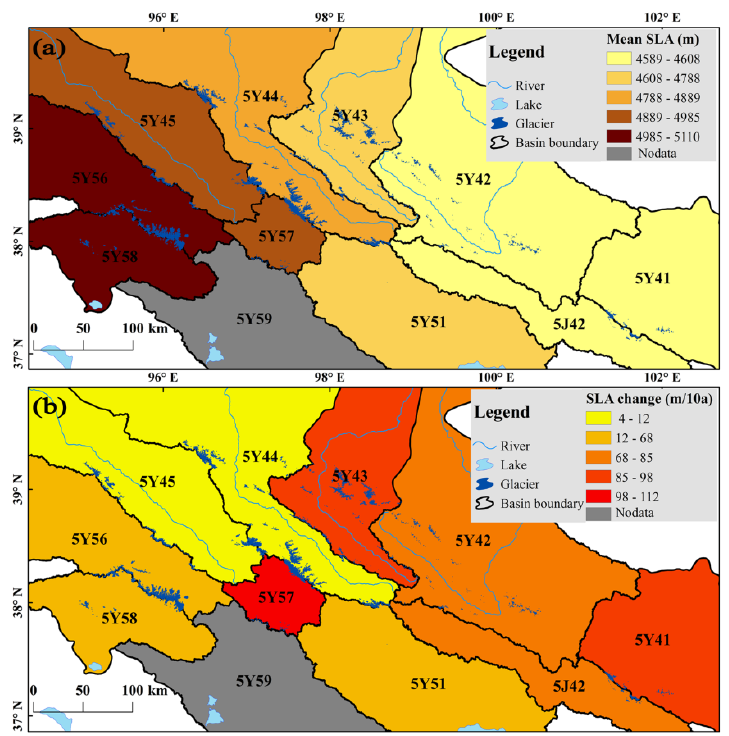
Figure 13. The glacier mean SLA of 10 sub-basins of the Qilian Mountains during 1989–2018 ( a ), and the variation of glacier SLA of 10 sub-basins during 1989–2018 ( b ).